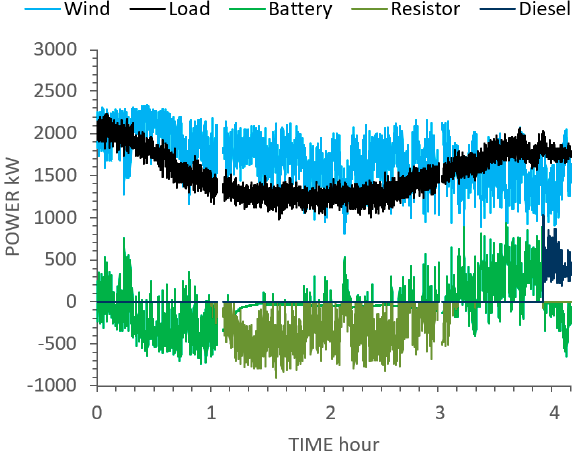
Figure 3. King Island generation showing system transition between wind (light blue), battery (light green), resistor (dark green, 1–3 h) and diesel (dark blue, post 4 h) isochronous control.